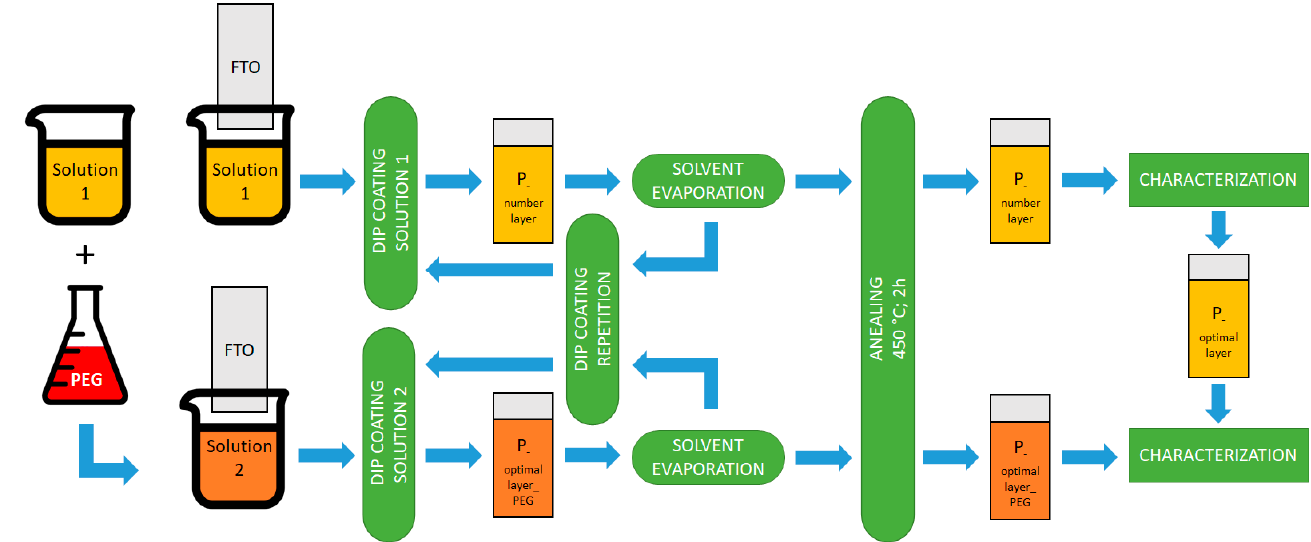
Figure 1. A simpli fi ed schematic of the procedure followed to obtain the TiO 2 thin fi lms on FTO Figure 1. A simplified schematic of the procedure followed to obtain the TiO 2 thin films on FTO substrate by dip-coating method. substrate by dip-coating